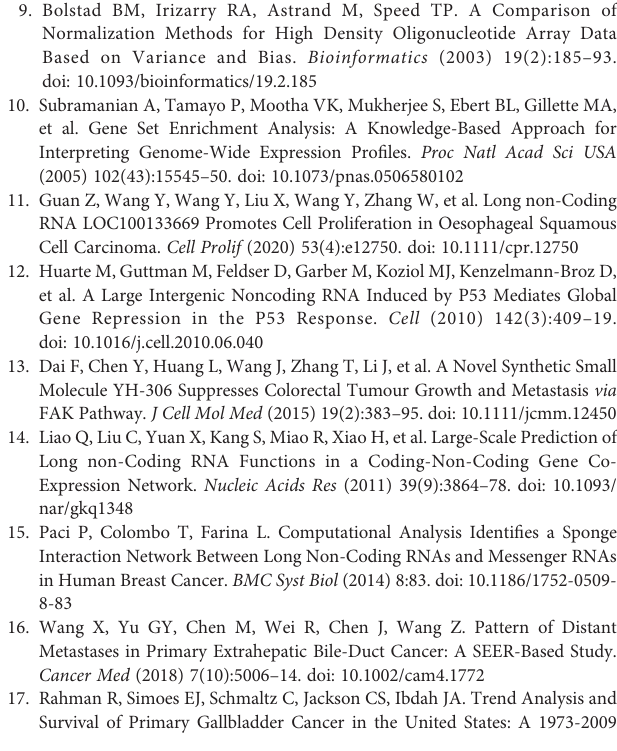
Supplementary Figure 1 | The expression of LINC01410 was determined by qRT-PCR in NOZ cells after transfection with the siRNA or siRNA-NC. Supplementary Figure 2 | The expression of LINC01410 was determined by qRT-PCR in GBC-SD cells after transfection with the LINC01410 overexpression lentiviruses and its negative control